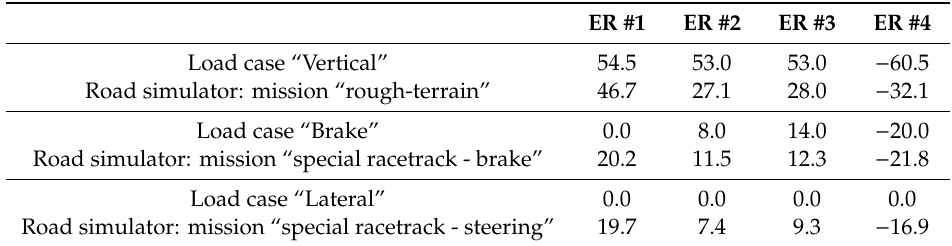
Table 5. Output stresses from MSC / AdamsCar (Multibody Simulation MBS) and the related road simulator time